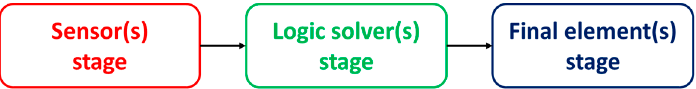
Figure 4. Functional block diagram of a generic safety instrumented system.